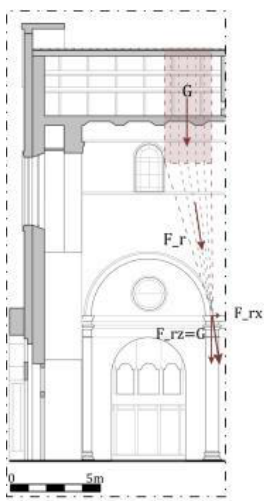
Figure 11. Use of the centered fan for the upper band The combination of the upper part of the wall and the fans forms natural discharge arches, transmitting the weight diagonally, to the pulvini . The inclined forces acting on the pulvini are characterized by a vertical component corresponding to the load and by a horizontal component resulting from the shear stress, born